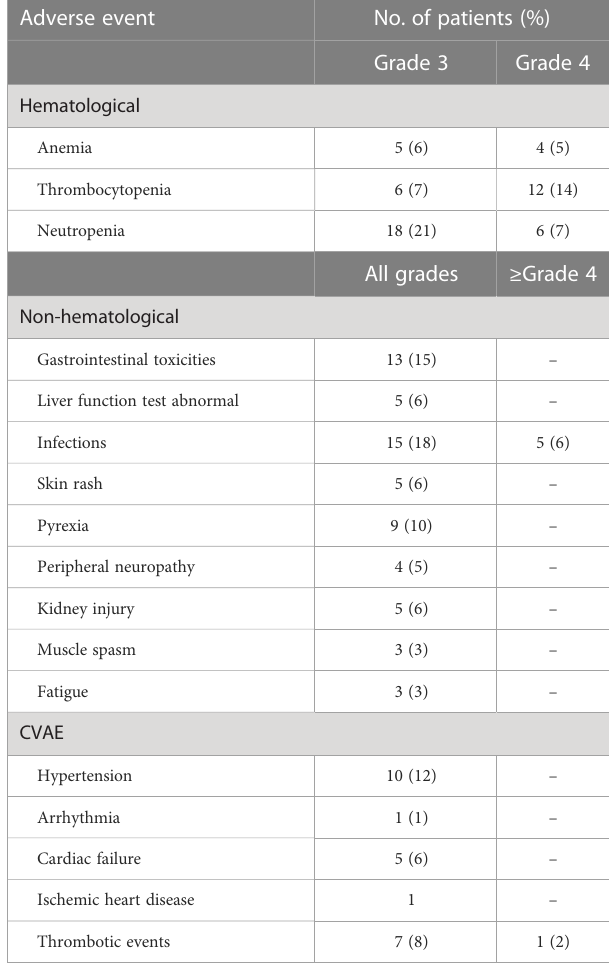
TABLE 4 Main toxicities (all grades and grade ≥